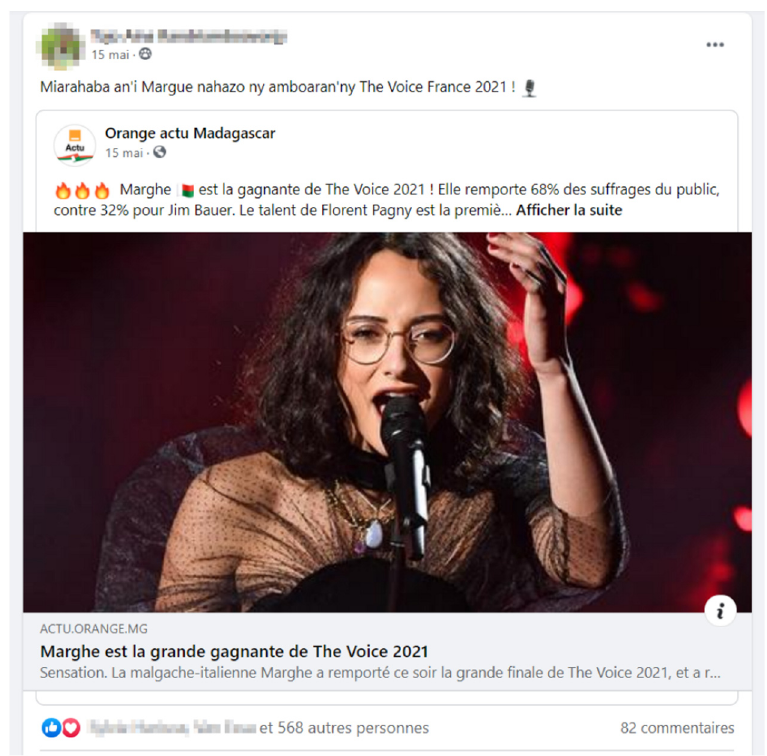
Figure 3. Capture of a post on ‘Marghe’ in the ‘Za Koa Hanorina Group.